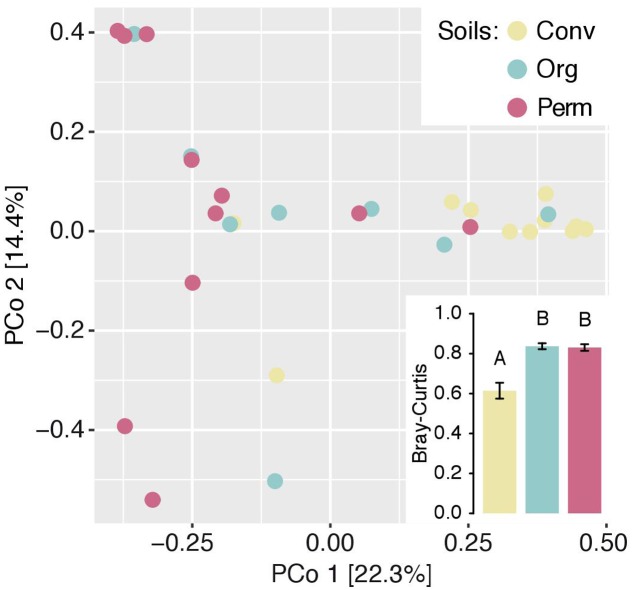
Variation between naranjilla root communities from trap cultures. Differences between communities were assessed with principal coordinate analysis (PCoA) based on Bray–Curtis dissimilarity. Points in the unconstrained ordination represent individual samples and are colored by the type of soil used for the trap cultures. Data was subsampled to the sequence number of the sample with the lowest sampling depth. Percentage of variation given on each axis refers to the explained fraction of total variation in all samples. Inset: Average dissimilarity within groups. Each sample was compared with all other samples within its group and these Bray–Curtis dissimilarity were averaged for each sample and plotted by soil groups.